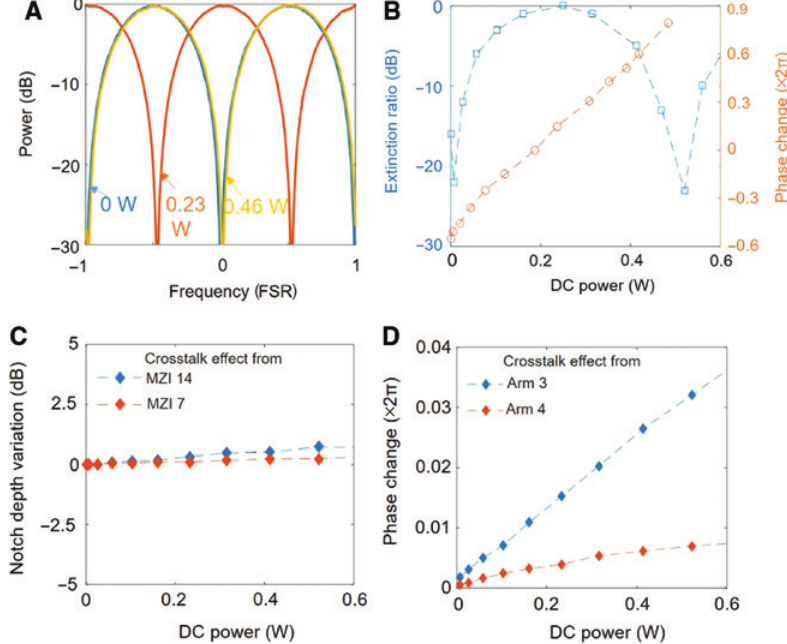
Figure 3: Characterization results of the sections between input 8 and output 8 (MZI 15 connected with arms 1 and 2): (A) spectral shift when arm 2 has DC power; (B) ER and phase change of MZI 15; (C) thermal cross-talk-induced spectra null depth variation (cross-talk from MZI 14 and MZI 7); (D) thermal cross-talk-induced phase change (cross-talk from arms 3 and 4) with respect to the applied DC